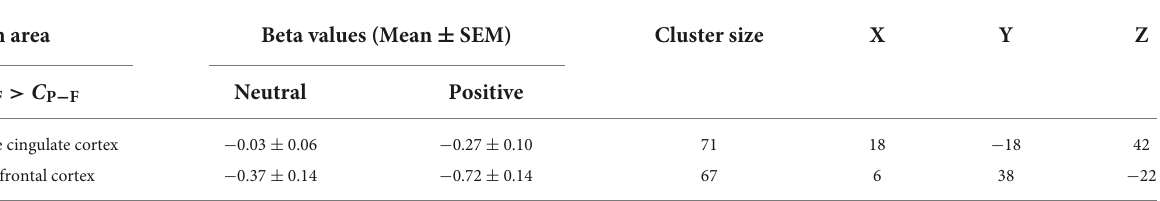
TABLE 2 Brain areas showing significant differences in between-condition